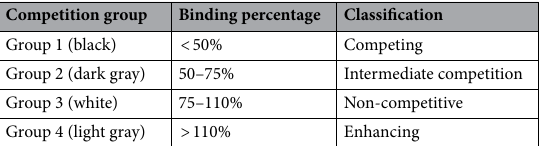
Table 3. Classification of Ebola antibodies in the competition assay into competition groups based on their percent binding